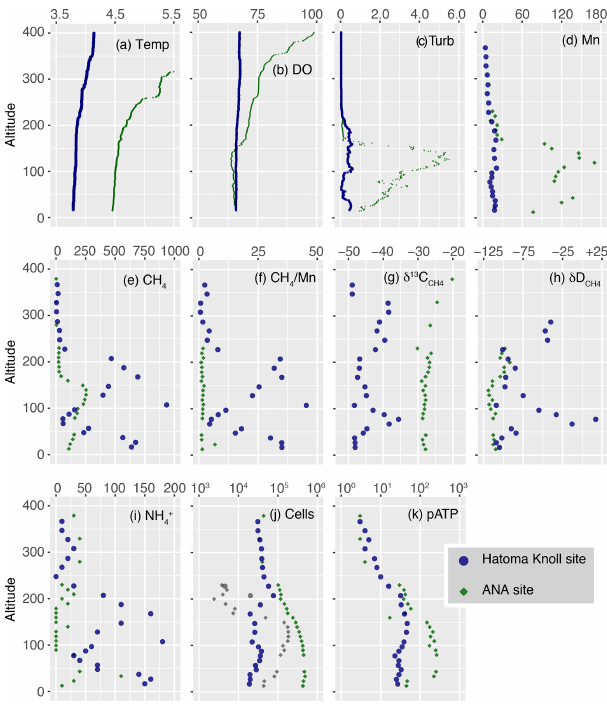
Figure 2. Vertical profiles of measured parameters. The y axis rep- resents altitude from the seafloor at each site. (a) Temperature. (b) DO level (µmolkg − 1 ). (c) Turbidity (FTU). (d–e) Manganese and CH 4 concentrations (nmolL − 1 ). (f) Methane / manganese ra- tio. (g–h) Carbon and hydrogen isotope ratios of CH 4 (‰). (i) Con- centrations of ammonium (nmolkg − 1 ). (j) Total cell density (col- ored) as well as HSS (grey) with logarithmic x axis (cellsmL − 1 ). (k) pATP concentration (pmolL − 1